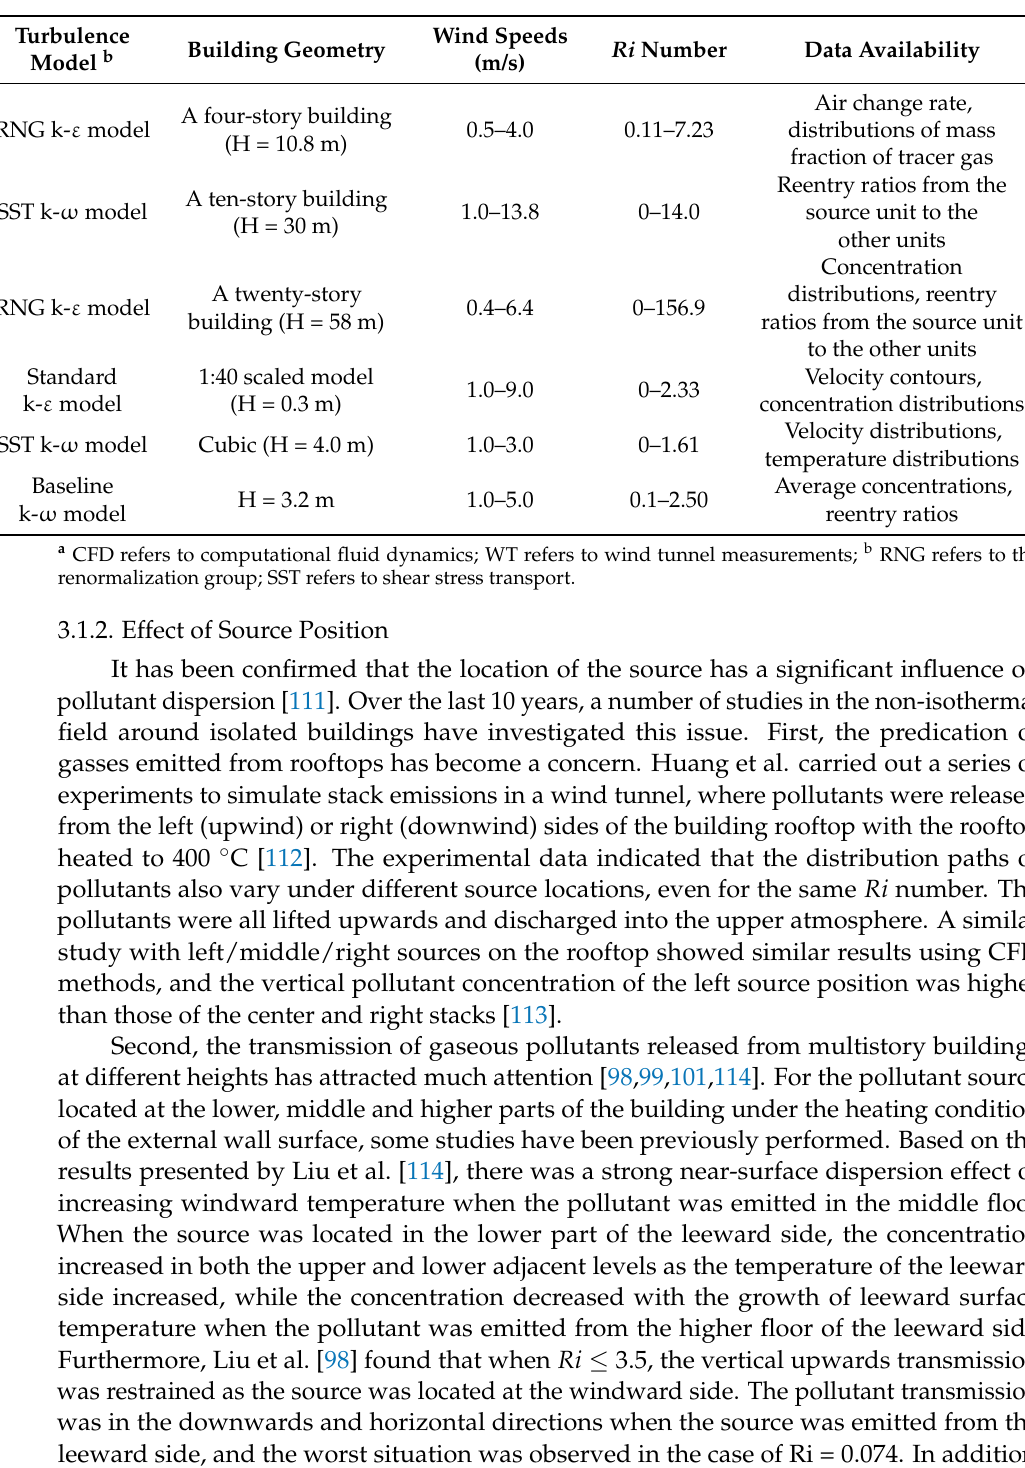
Table 1. Studies on approaching wind speed under non-isothermal conditions around an isolated